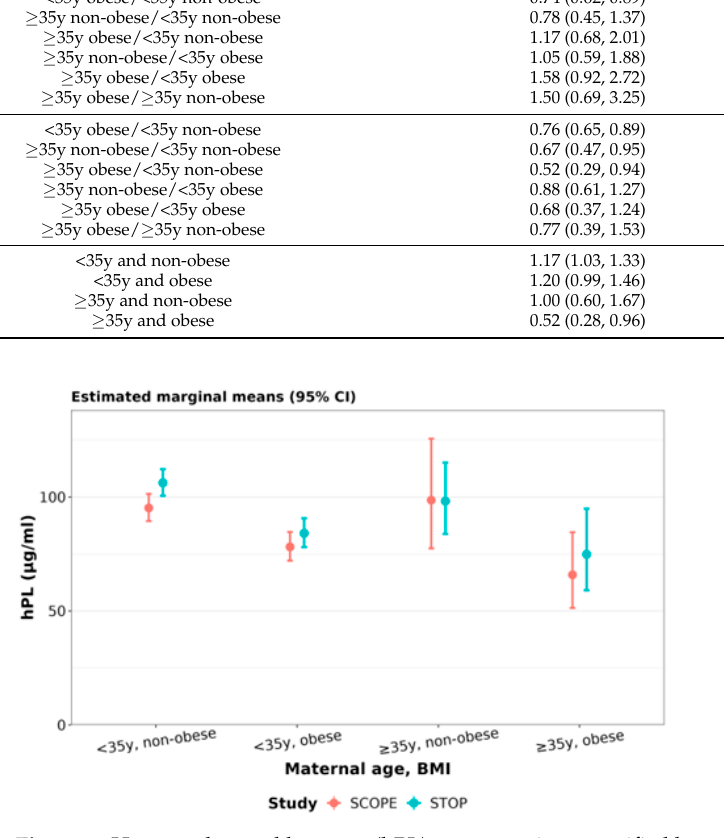
Figure 7. Human placental lactogen (hPL) concentrations stratified by maternal age and BMI: hPL in early gestation SCOPE (N = 465) and STOP (N = 684) women was stratified by maternal age and BMI status. Women were stratified as younger than 35y or 35y and older, and non-obese (healthy BMI) and